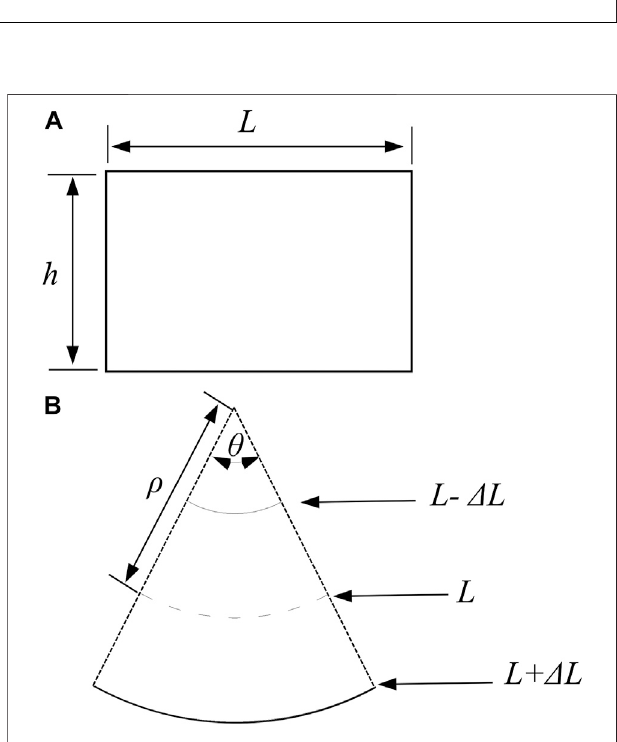
FIGURE2 | Schematic diagram ofthe rodunit before and after bending. (A) Undeformed unit. (B) Deformed